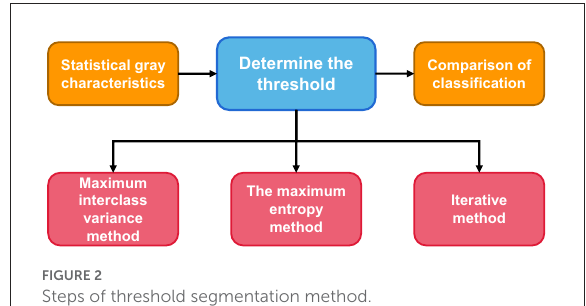
FIGURE2 Steps of threshold segmentation